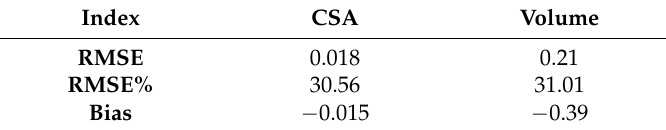
Figure 8. The relationship between spectral data between the UAV and Pléiades bands (×10 9 ). Table 6. Basic errors of CSA and volume based on extrapolated data.